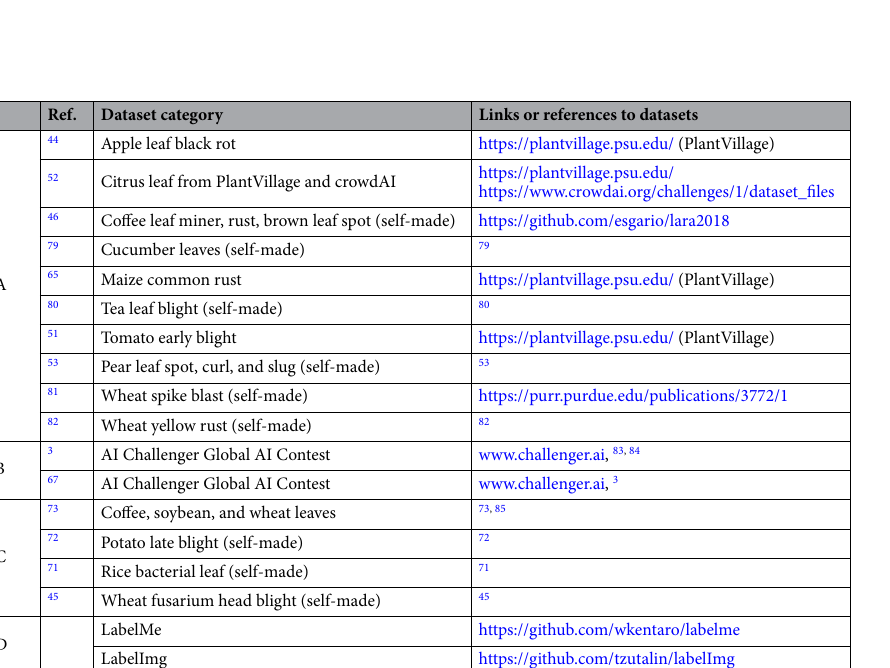
Table 1. Datasets and labeling software in the 16 studies, A for Classical CNN framework, B for Improved CNN architecture, C for CNN-based semantic segmentation network, and D for Labeling Software.